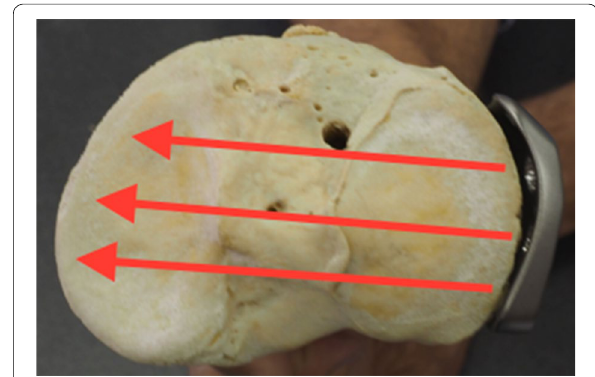
Fig. 1 Apical view of locking plate placed against tibia (Zimmer NCB proximal tibia system)